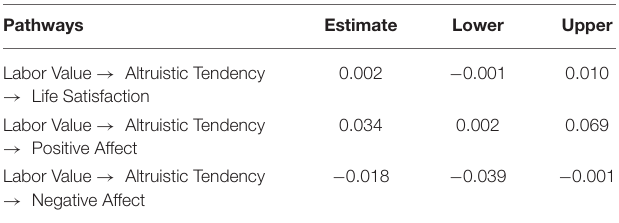
TABLE 3 | Standardized indirect effects and 95% confidence